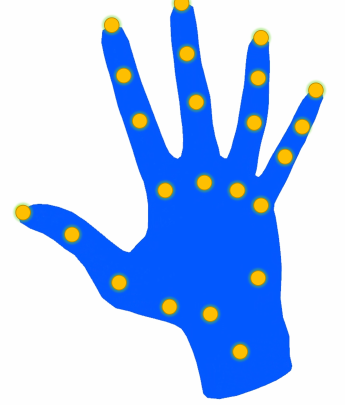
Figure 2. Hand points used to capture static